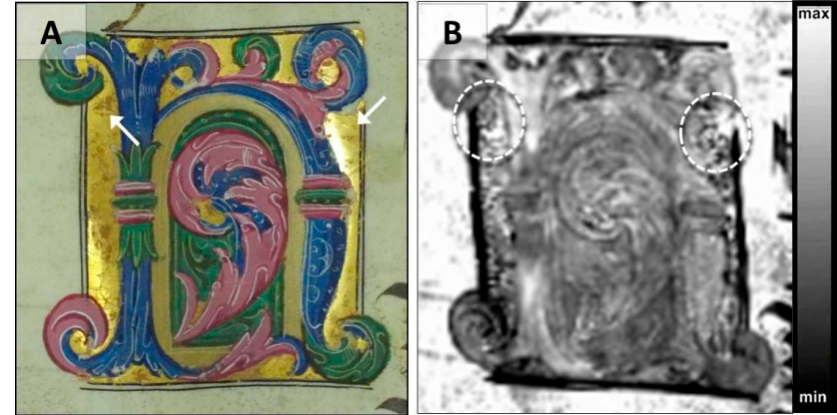
Figure 9. Antiphonary, XV century, Biblioteca Angelica of Rome. ( A ) Photograph of the illuminated letter of folio 117 verso , where the arrows indicate the craquelure ; ( B ) thermogram showing extended detachments from the substrate around some of the observed cracks marked by circles [51].